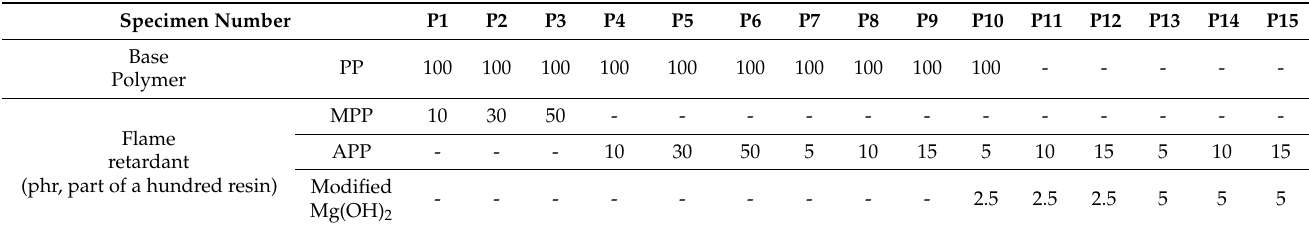
Table 1. Mixing ratio of various flame retardants added to compounds for composite material property